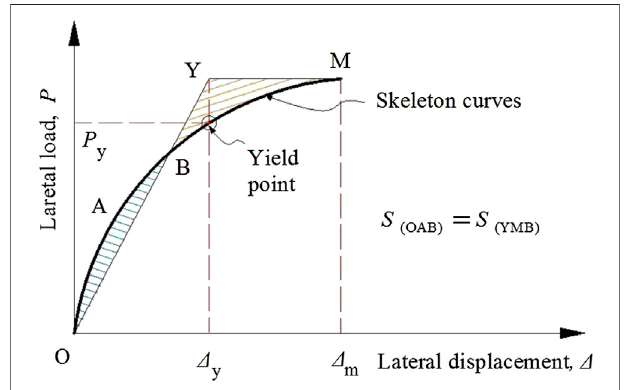
FIGURE 8 | Diagram of Energy equivalent method.